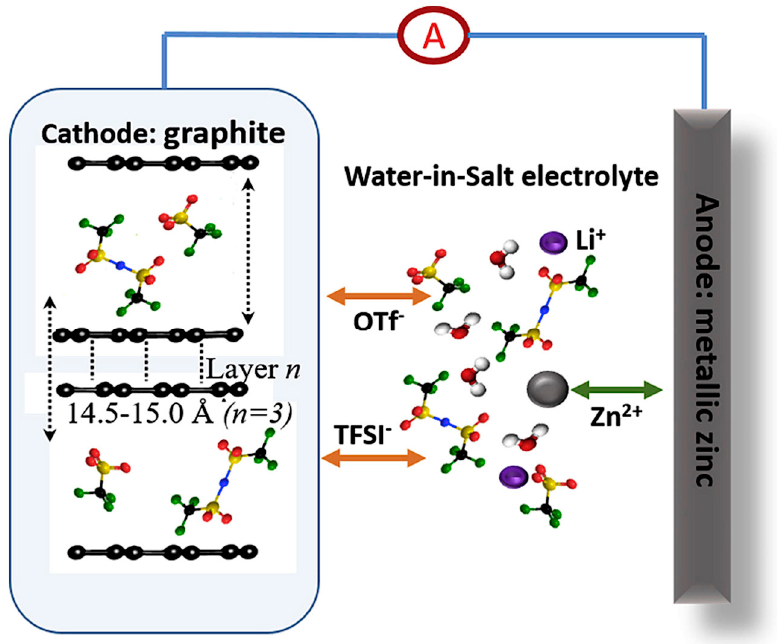
Figure 4. Schematic of TFSI − and TfO − anions intercalated into graphite with a repeating distance ranging from 14.5 nm to 15.0 Å in aqueous dual-ion battery, where positive electrode operates with the anion intercalation and the negative feature zinc plating/stripping. Reproduced with permissions from Ref. [55]. Copyright © 2020 Elsevier Ltd.